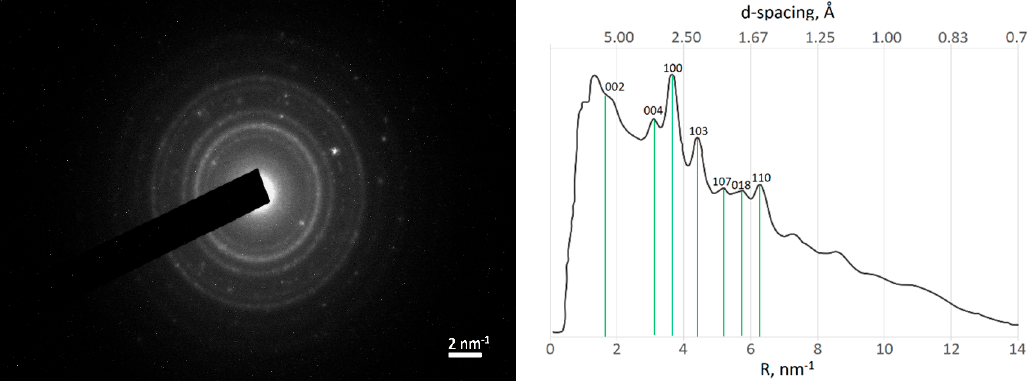
Figure 4. Selected area electron diffraction (SAED) pattern of the PAF-20-NiWS catalyst after reaction in the presence of sulfur.